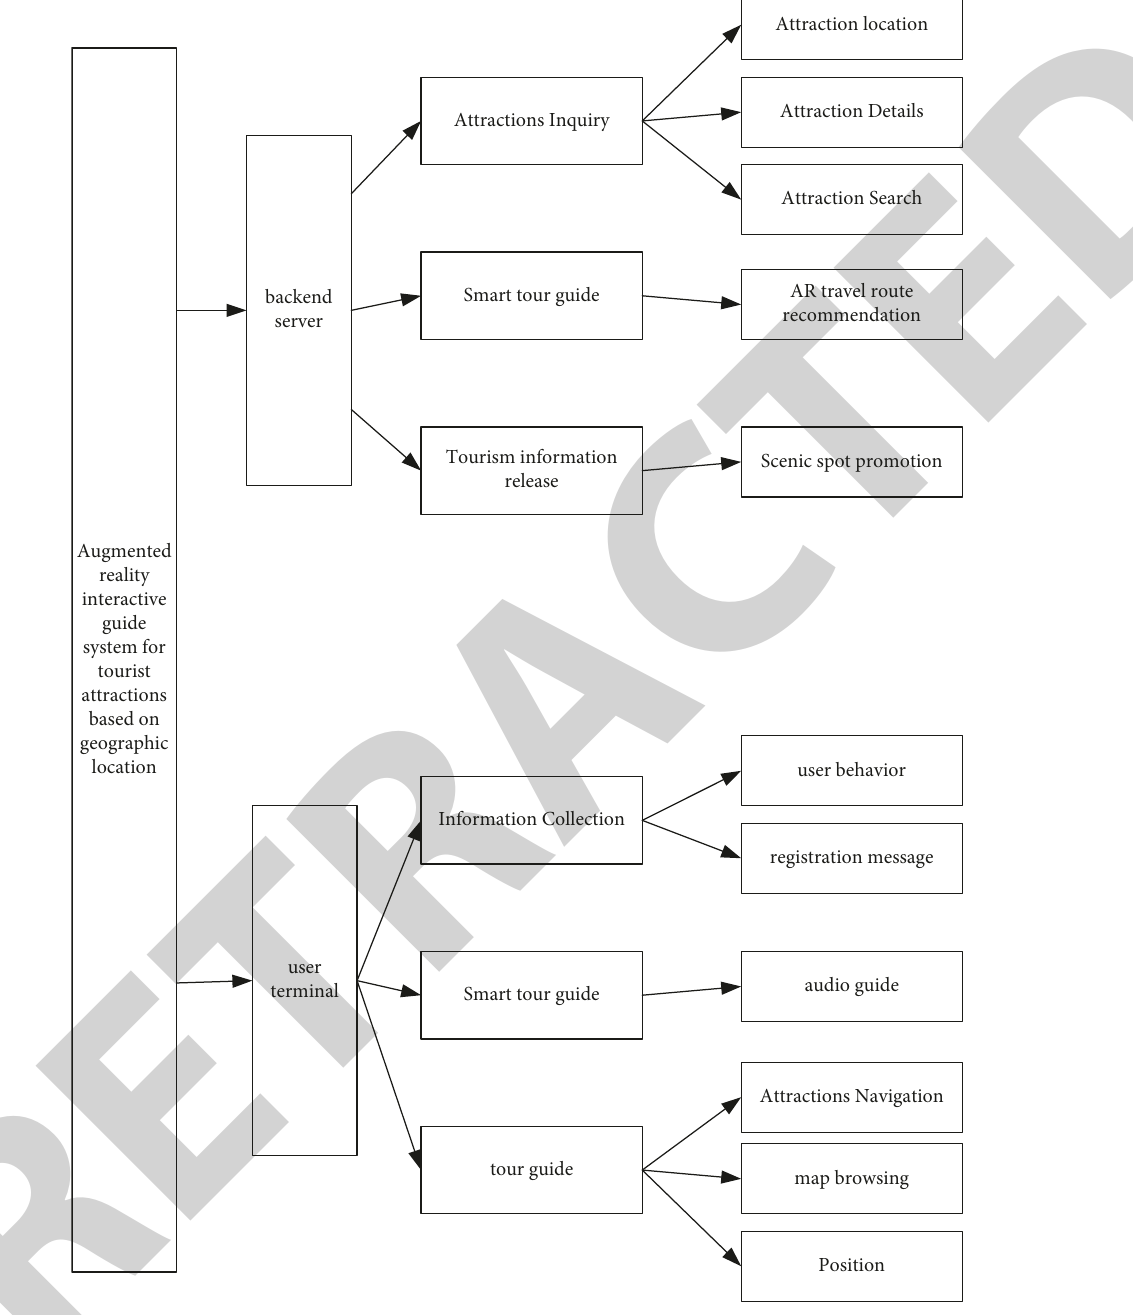
Figure 9: AR interactive scenic tourist guide